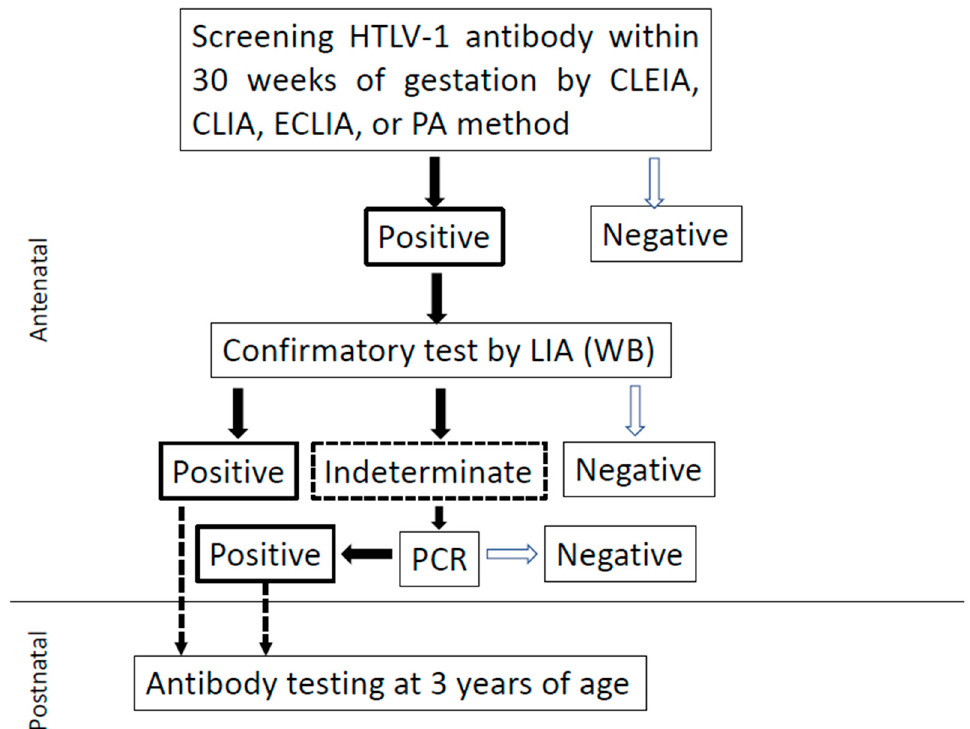
Figure 4. Algorithm for diagnosing HTLV-1 infection in Japan. Currently, no confirmatory tests using Western blotting are conducted in Japan. Flowchart for identifying HTLV-1 carriers among pregnant women. CLEIA, chemiluminescent enzyme immunoassay; CLIA, chemiluminescent immunoassay; ECLIA, electrochemiluminescent immunoassay; PA, particle agglutination; WB, Western blotting; LIA, line immunoassay; PCR, polymerase chain reaction. The figure is reproduced from Itabashi et al. [54]. For further details, please refer to Okuma et al.